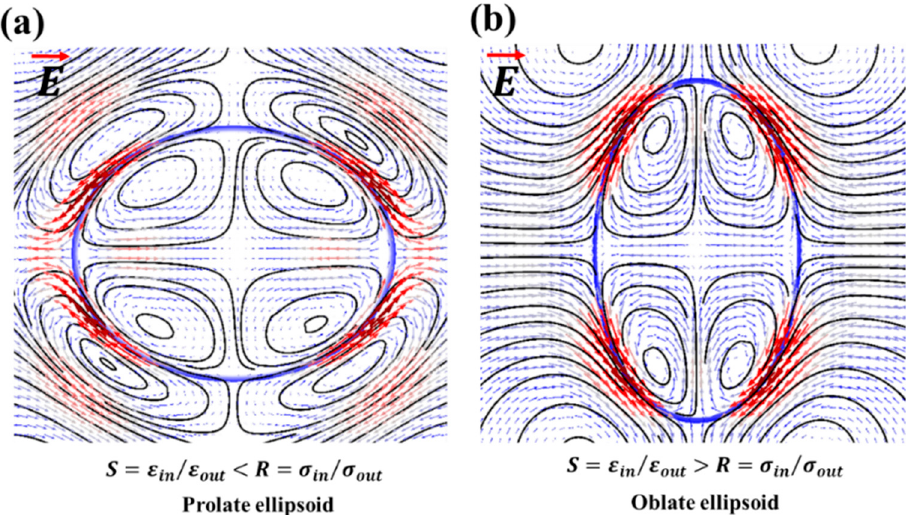
Figure 3. Simulation results pertaining to the distortion of the particle-free droplet under an applied electric field: ( a ) the prolate deformed droplet; the flow is from the equator towards the droplet poles; ( b ) the oblate deformed droplet; the flow is from the poles towards the droplet equator. Here, S is the permittivity ratio, whereas R is the conductivity ratio between the droplet and the ambient liquid.